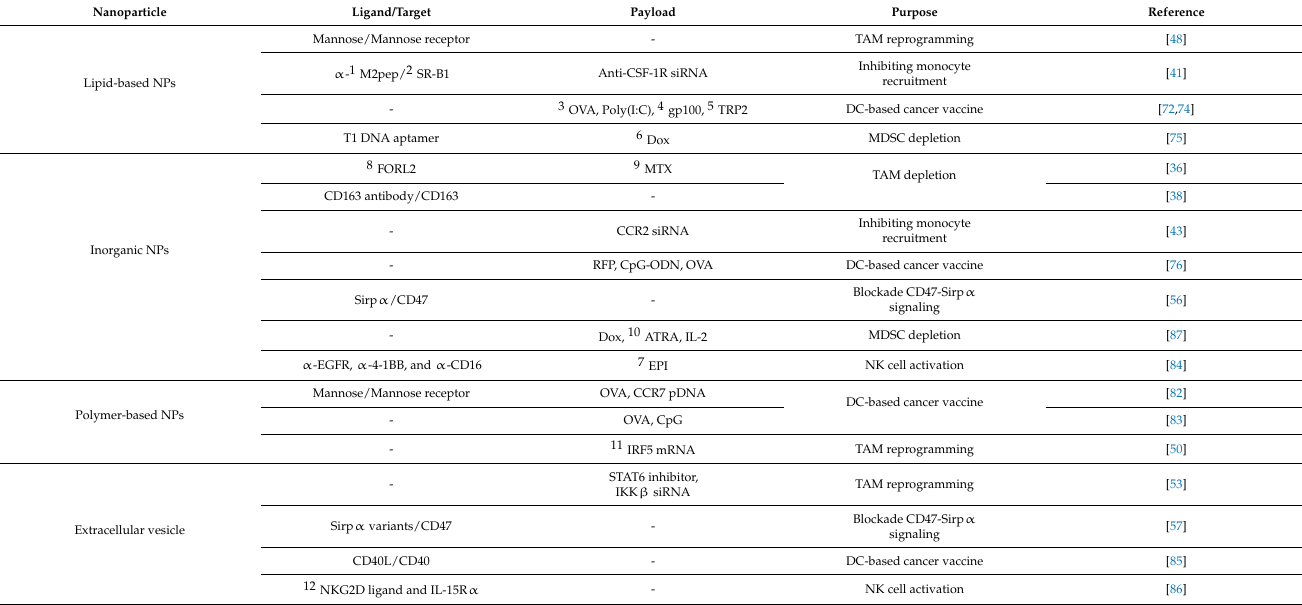
Table 2. Overview of nanoparticles with payload and targeting moieties for cancer